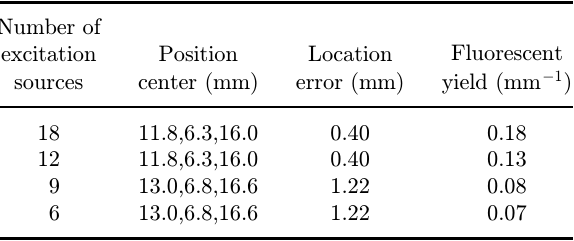
Table 6. Impact of di®erent excitation sources on the proposed